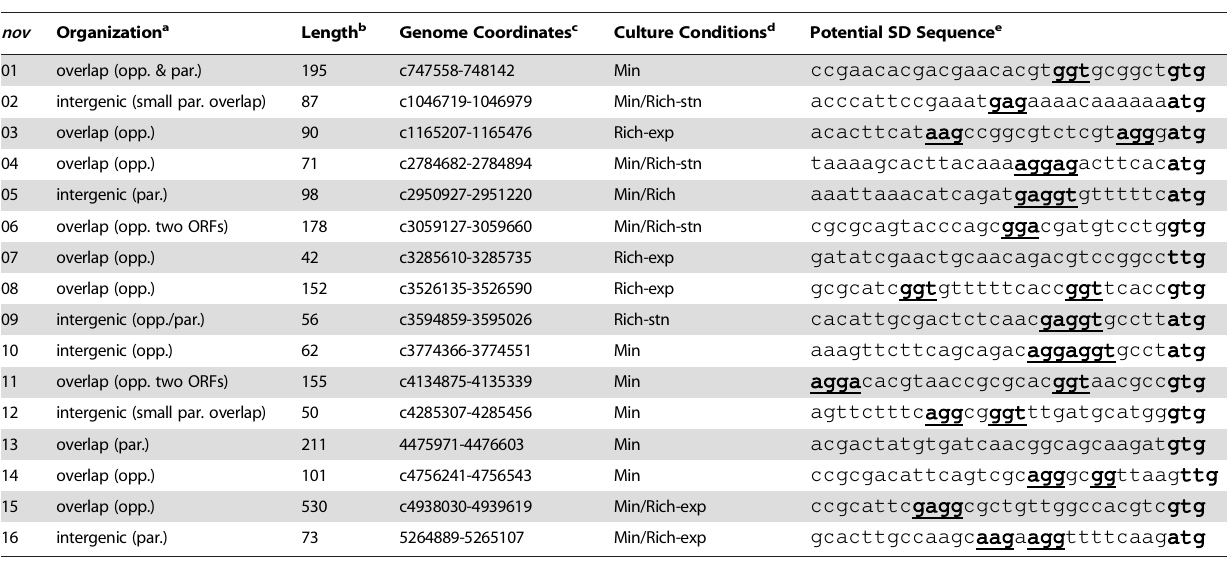
nov Organization a Length b Genome Coordinates c Culture Conditions